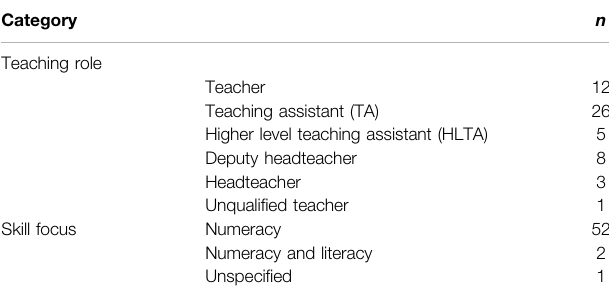
TABLE 2 | Teaching Roles of the Teaching Staff Who Completed the Online Survey and the Skills that they Reported Supporting Using the SAFMEDS